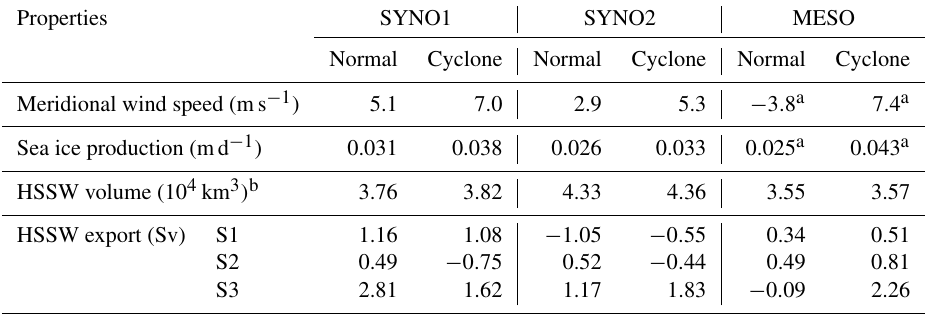
Table 1. Comparisons of polynya-averaged sea ice production rates and HSSW properties under the normal and selected synoptic-scale and mesoscale cyclones (SYNO1, SYNO2 and MESO) for the RISP. The normal values are calculated prior to these events, from 06:00 on 13 July to 18:00 on 13 July for SYNO1, 12:00 on 16 September to 00:00 on 18 September for SYNO2, and 18:00 on 20 June to 12:00 on 21 June for MESO. The cyclone time ranges used in the calculation are consistent with those shown in Figs. 4 and 8 and Fig. S1 in the Supplement. Properties SYNO1 SYNO2 MESO Normal Cyclone Normal Cyclone Normal